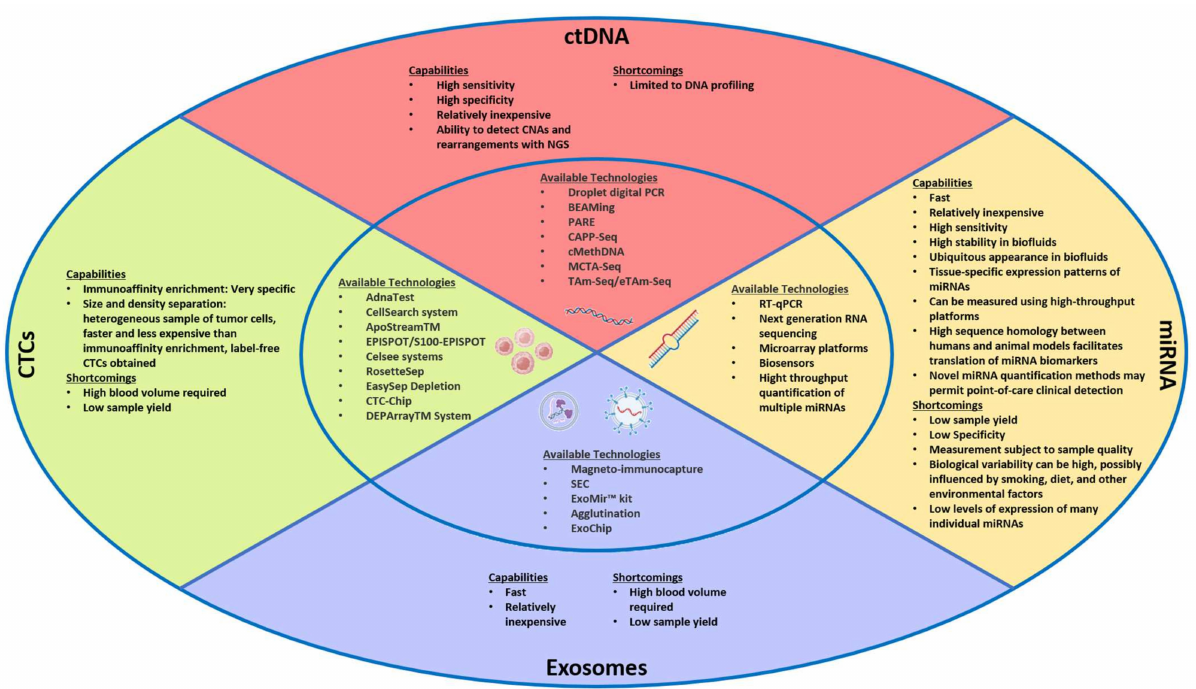
Figure 2. Comparison of liquid biopsy techniques. Abbreviations: DNA, deoxyribonucleic acid; PCR, polymerase chain reaction; ctDNA, circulating tumor DNA; CNA, copy number alterations; NGS, next generation sequencing; ddPCR, droplet digital PCR; RNA, ribonucleic acid; CTC, circulating tumor cells; miRNA,